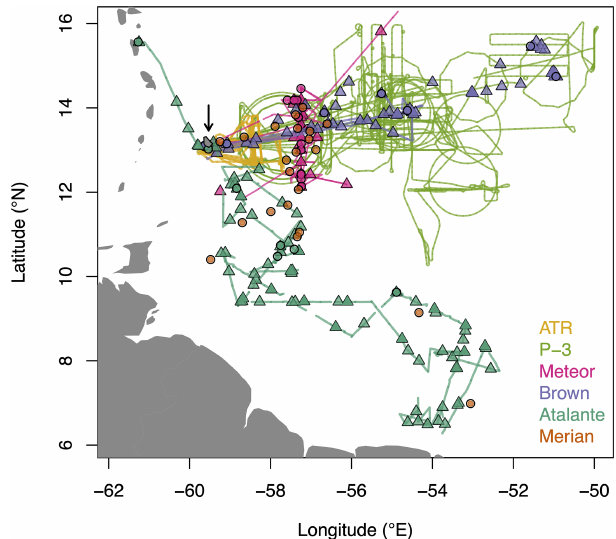
Figure 2. Map of continuous (water vapor) and discrete (rain and seawater) isotopic sampling during the EUREC 4 A 2020 field ex- periment. Tracks for the various aircraft and ships are plotted only for periods during which water vapor isotopic sampling occurred. Circles and triangles indicate locations of rain and seawater sam- pling, respectively. The arrow points to Barbados, whose landmass is outlined in black. Readers are referred to Stevens et al. (2016) for a detailed map of Barbados and a photograph of Deebles Point and the Barbados Cloud Observatory